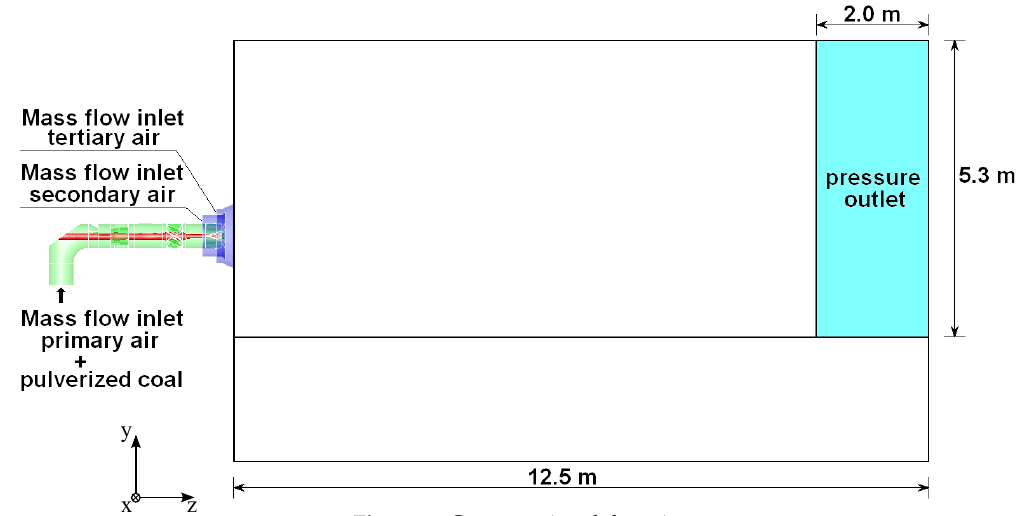
Figure 3. Computational domain.